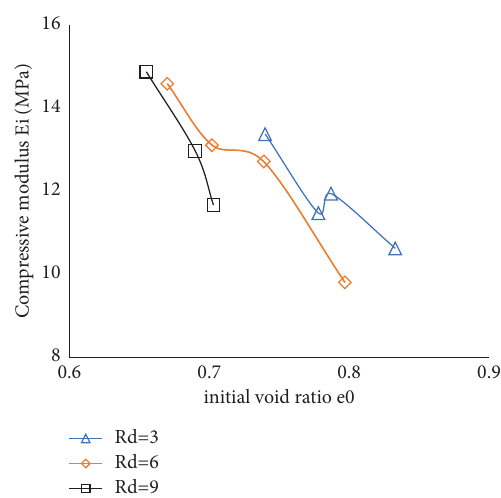
Figure 6: Stress-strain curve of the breakable ball pack.